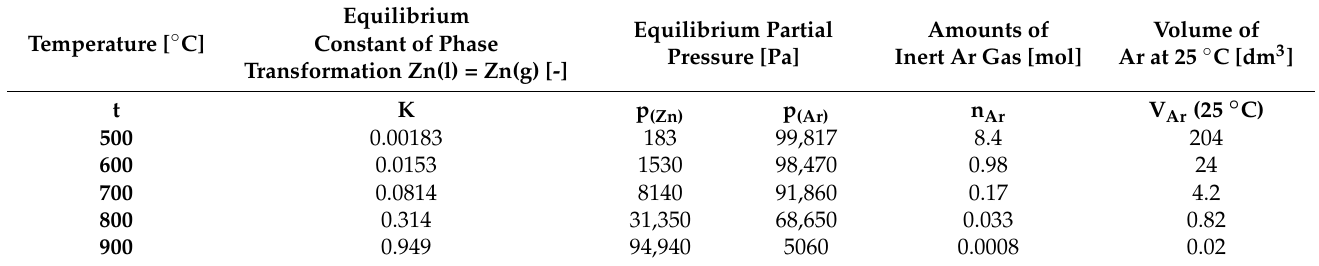
Table 3. Inert gas amount (nAr, V Ar ) at equilibrium state in system (Zn+Ar) after the evaporation of